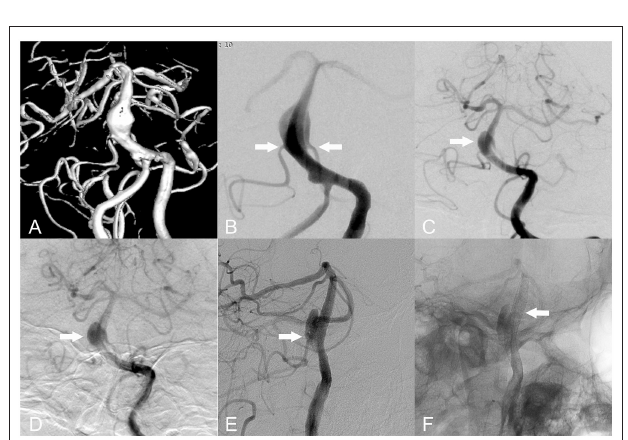
FIGURE 2 | Basilar fusiform aneurysms. (A,B) Bilateral anterior inferior cerebellar arteries (AICAs) originate from the aneurysmal body (white arrow). (C,D) A 9-month follow-up angiography revealed residual aneurysm. (E) Blood flow through aneurysmal bodies supplied blood to the AICA (white arrow). (F) A 9-month follow-up angiography revealed no intra stent stenosis (white